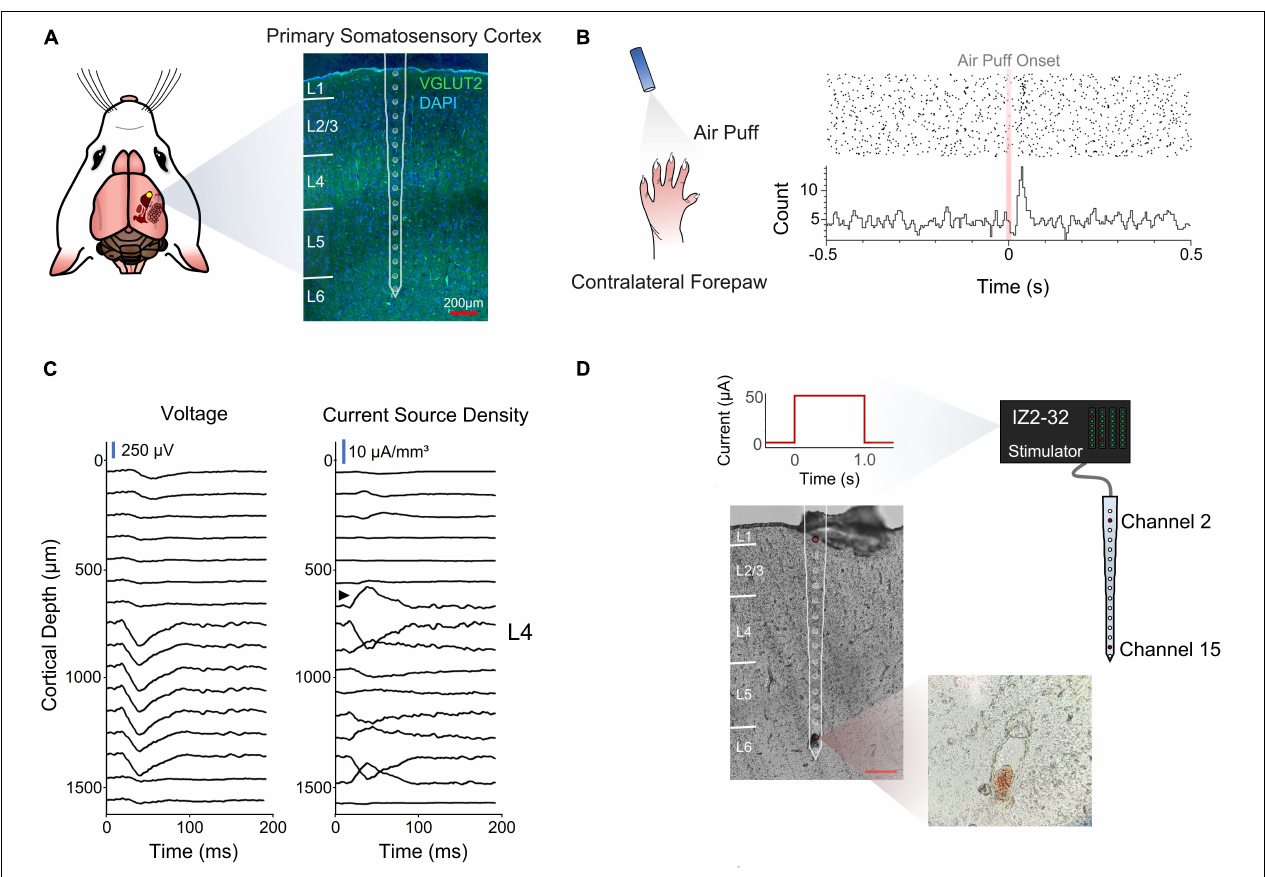
FIGURE 1 | Electrode implantation and cortical depth assessment. (A) Coronal section of the implantation site stained for VGLUT2 and DAPI for cortical layer identification. (B) Perievent stimulus time histogram of an air puff onset to the contralateral forepaw. (C) Voltage traces and inverse current source density. Black arrow designates sink characteristic of thalamic input into layer 4. (D) Post-mortem depth assessment via electrolytic lesion of the